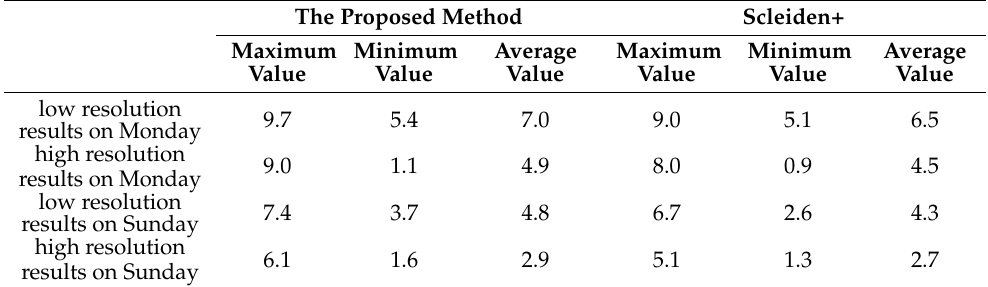
Figure 9. Low-resolution spatial communities discovered by two methods during morning rush hours: ( a ) spatial communities identified by the proposed method on Monday; ( b ) spatial communities identified by Scleiden+ on Monday; ( c ) spatial communities identified by the proposed method on Sunday; ( d ) spatial communities identified by Scleiden+ on Sunday. Table 2. AF index values of the spatial communities identified by the proposed method and Scleiden+ during morning rush hours.